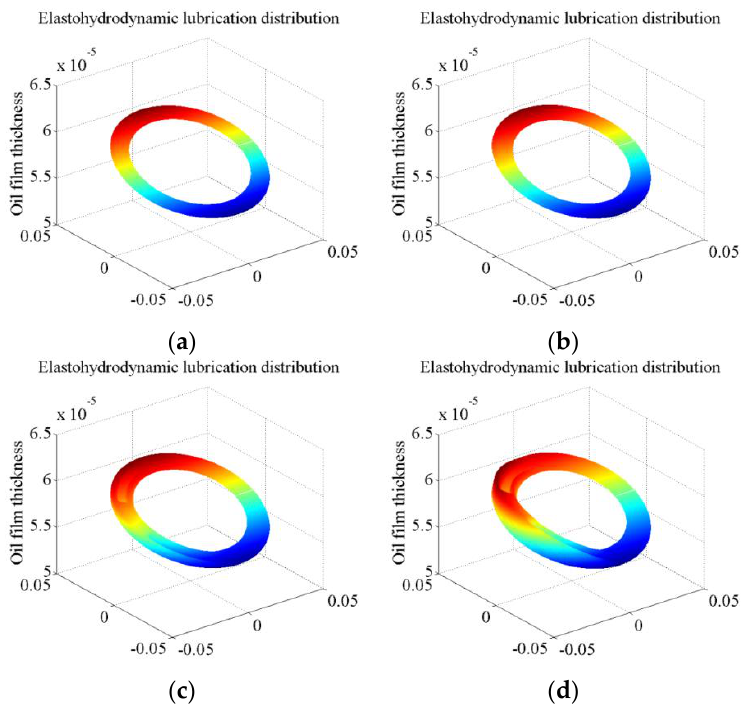
Figure 16. Effect of the sealing belt width on the oil film clearance under elastic deformation. ( a ) B = 0.010 m; ( b ) B = 0.011 m; ( c ) B = 0.012 m; ( d ) B = 0.013 m.